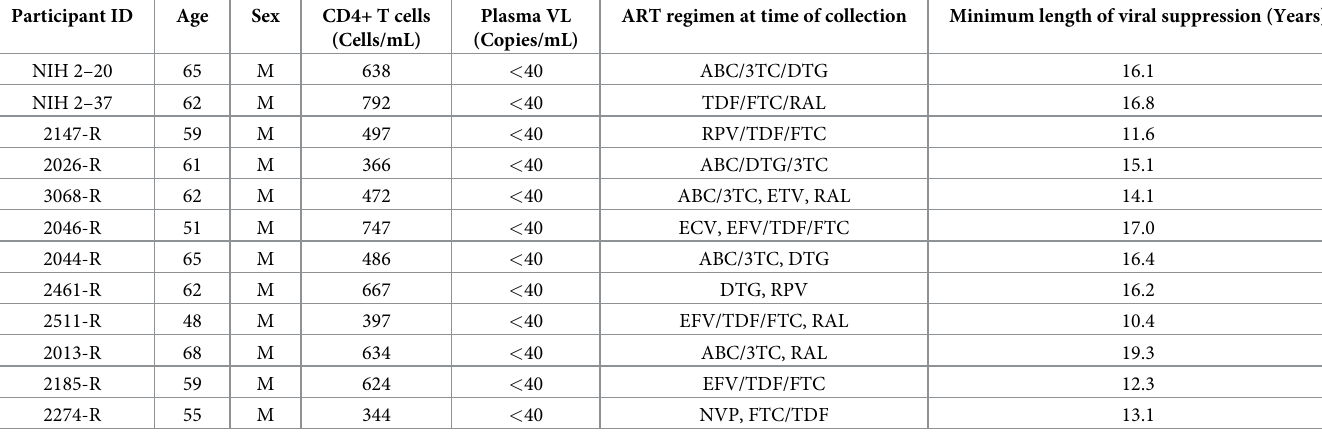
Table 1. HIV-Infected participant